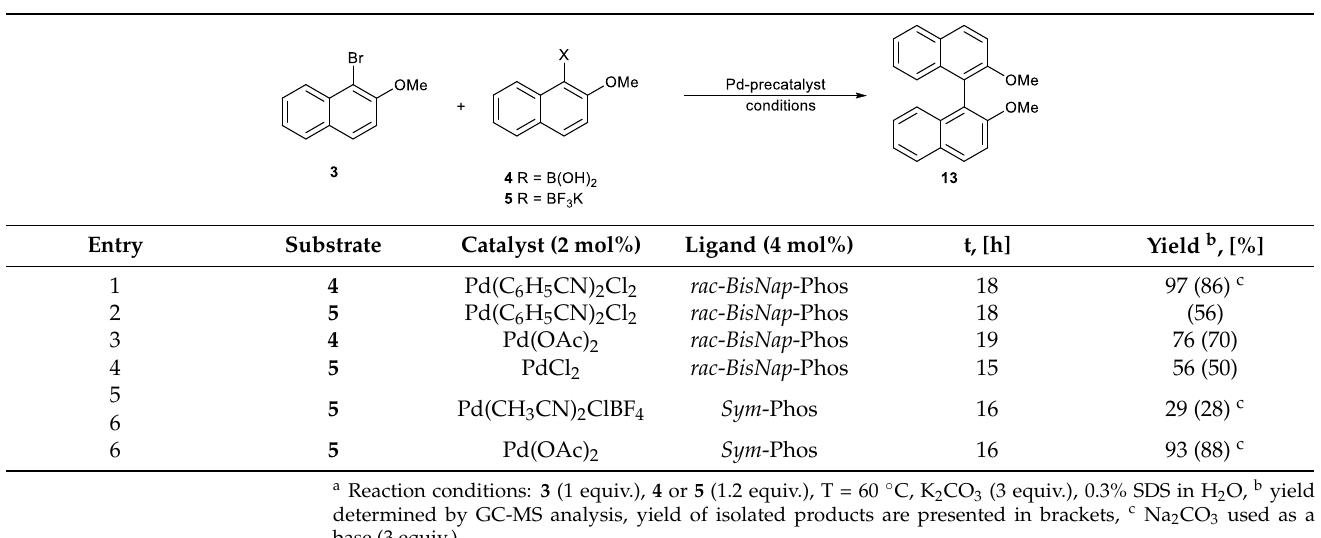
Table 3. Synthesis of 13 under microwave conditions a .